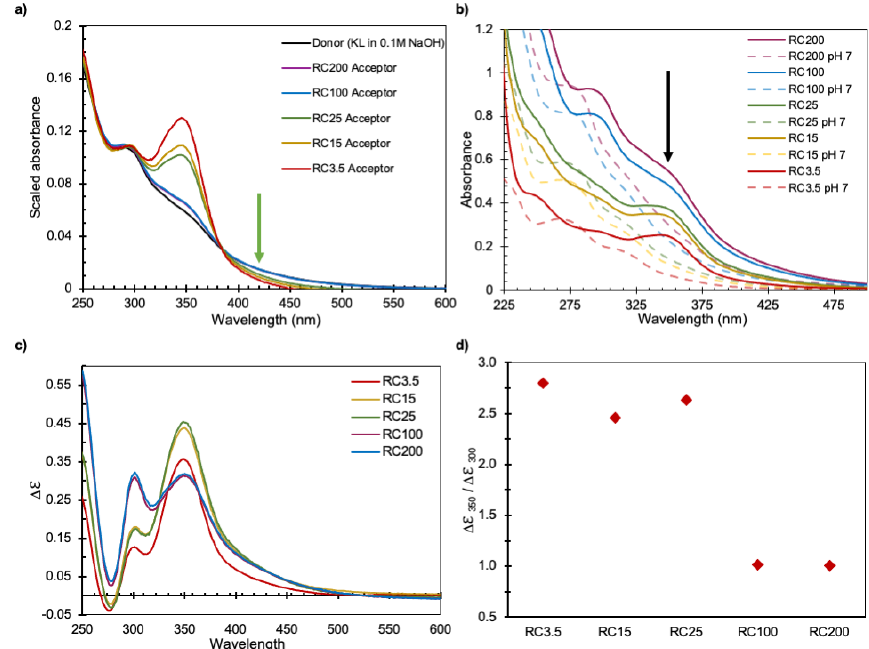
Figure 3. ( a ) Scaled UV-vis spectra of samples taken from the acceptor side of diffusion cells after 168 h; ( b ) UV-vis spectra of original samples taken from the acceptor side of diffusion cells (in 0.1 M NaOH), and their respective neutralized spectra; ( c ) Ionization difference spectra ( ∆ ε ) of samples from acceptor chambers collected at 164 h; ( d ) Ratio of ionization difference ( ∆ ε ) at 350 nm to 300 nm, which is proportional to the relative concentration of conjugated to unconjugated units [29,30].